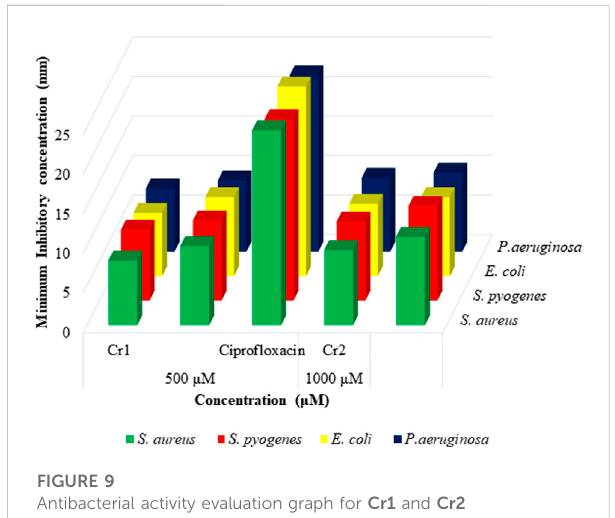
FIGURE 9 Antibacterial activity evaluation graph for Cr1 and Cr2 complexes.